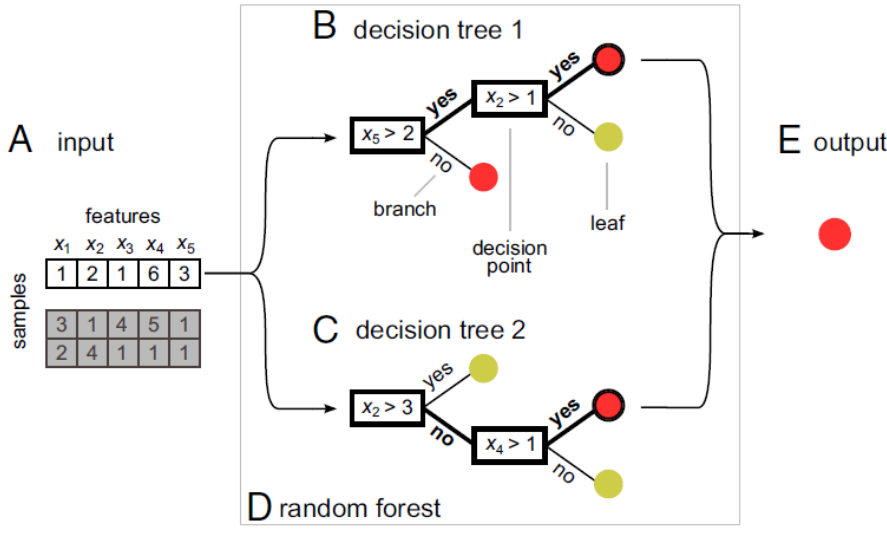
Figure 5. RF concept adapted from [37].